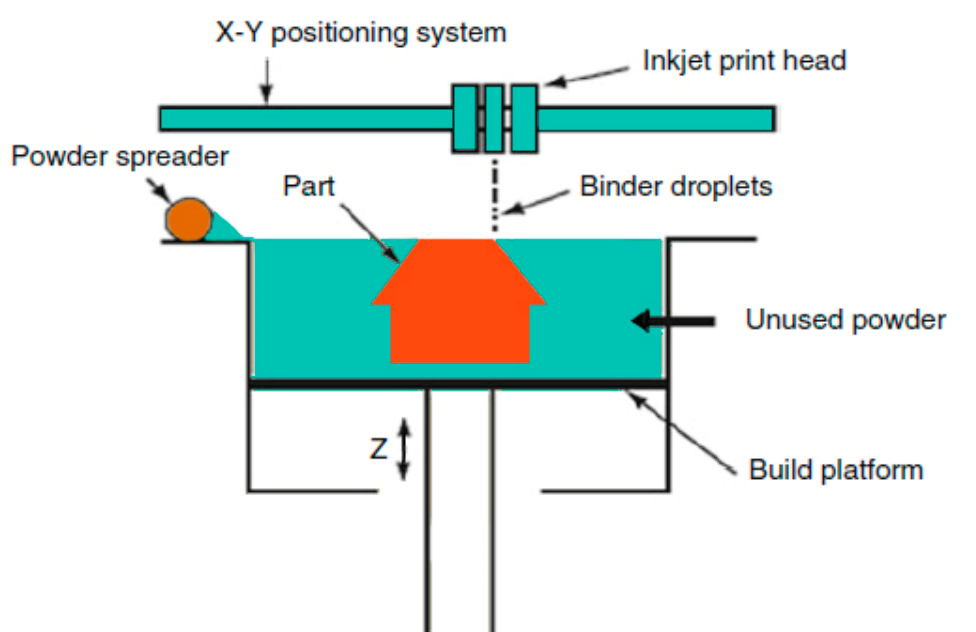
Figure 2. Schematic diagram of binder jetting mechanism [18].